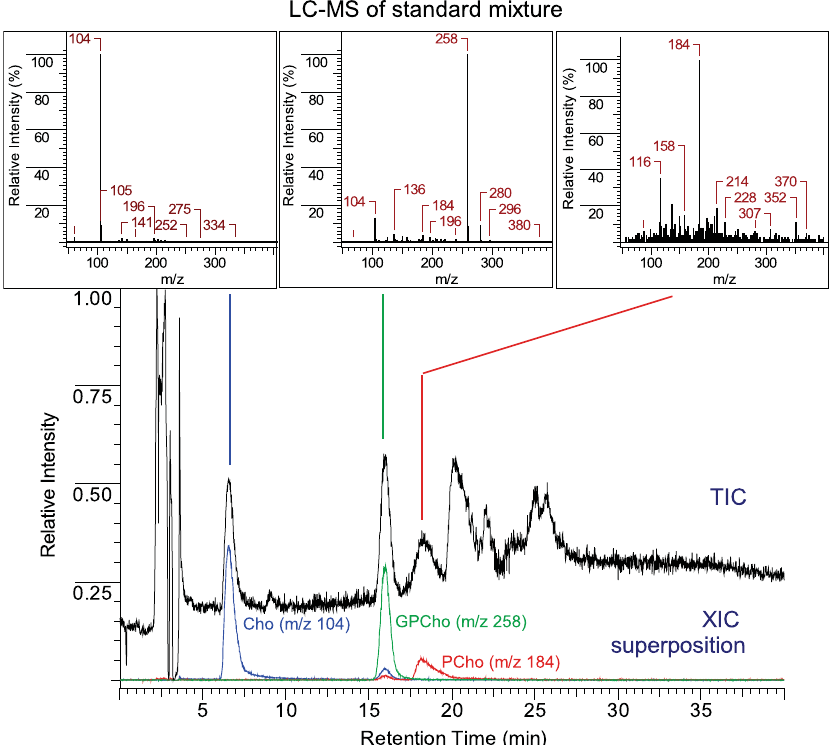
Fig. 3. LC/ESI-MS analysis of a standard mixture solution of Cho, PCho, GPCho in acetonitrile/water/methanol=7/1/2=v/v/v. Together with the Total Ion Current (TIC) Chromatogram (black trace), the extracted ion chromatogram (XIC) for Cho (blue trace), PCho (red traces), GPCho (green trace) are reported. The XIC chromatograms are obtained by selecting the suitable m/z values (namely 104 for free Cho, 184 for PCho and 258 for GPCho) and provide the elution curves of the three compounds. The three top panels represent the TOF-MS spectra acquired at elution of the three peaks. The Cho and PCho components occurring at the retention time of GPCho (at ca 16 min) are due to in-source fragmentation of the latter